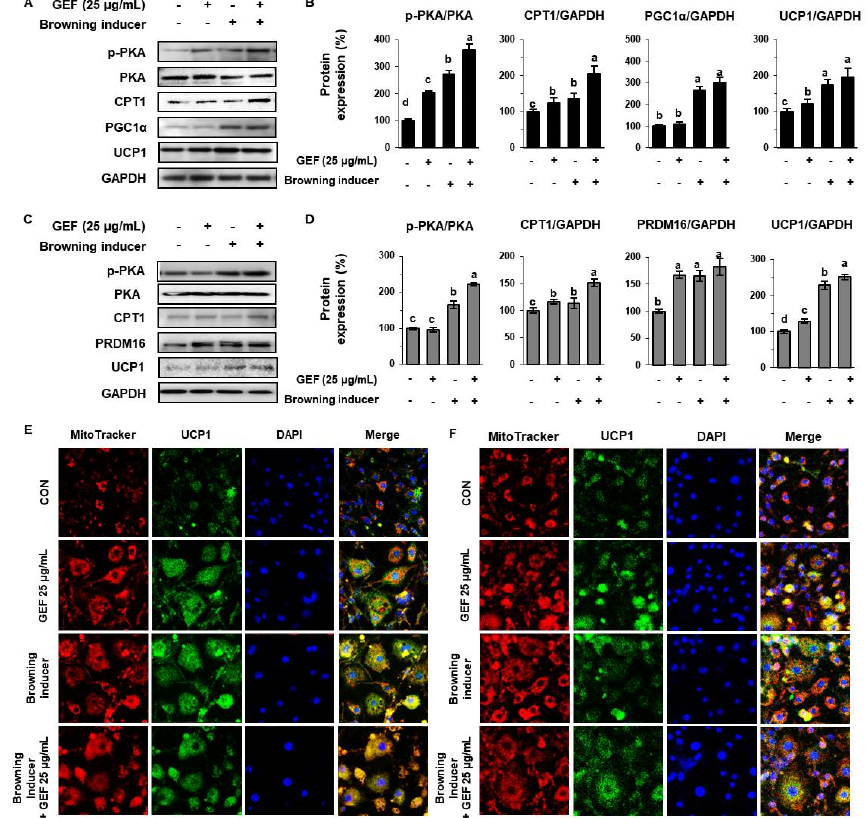
Figure 5. Additive effects of conventional browning inducers and GEF on thermogenesis in 3T3-L1s and SATs. ( A–B ) 3T3-L1s and ( C–D ) SATs were treated with 25 µM GEF with or without browning inducers (50 nM triiodothyronine and 1 mM rosiglitazone), and the expression of brown adipose tissue (BAT)-specific proteins was measured by Western blot analysis. ( E–F ) Immunofluorescence images of cells were captured at 800× magnification. Differentiated adipocytes were stained with MitoTracker Red and fixed with methanol, and then anti-UCP1 antibody and DAPI were applied (left, 3T3-L1s; right, SATs).